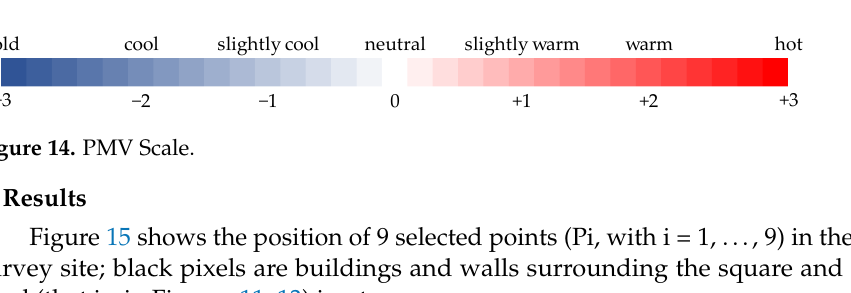
Figure 13. Permeable and traditional sampietrini pavement (S3).